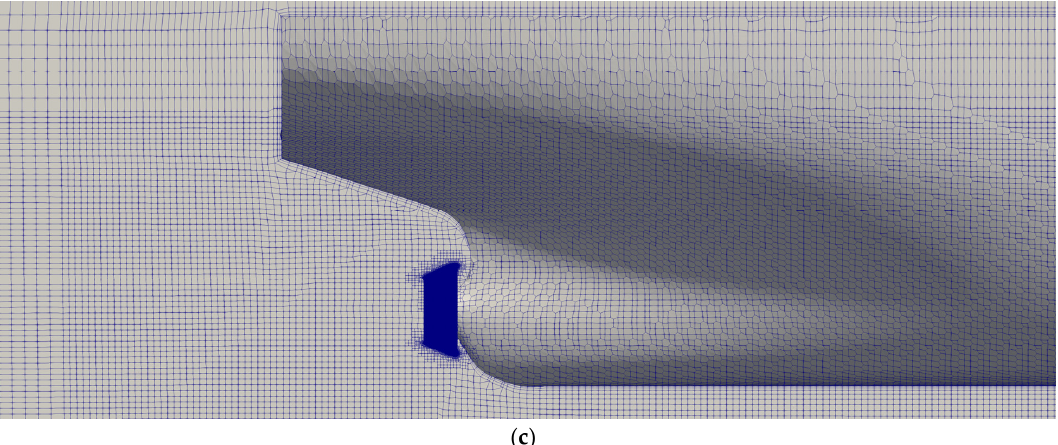
Figure 6. Local grid distribution with duct around ship stern and duct: ( a ) coarse grid; ( b ) medium grid; and ( c ) fine grid.